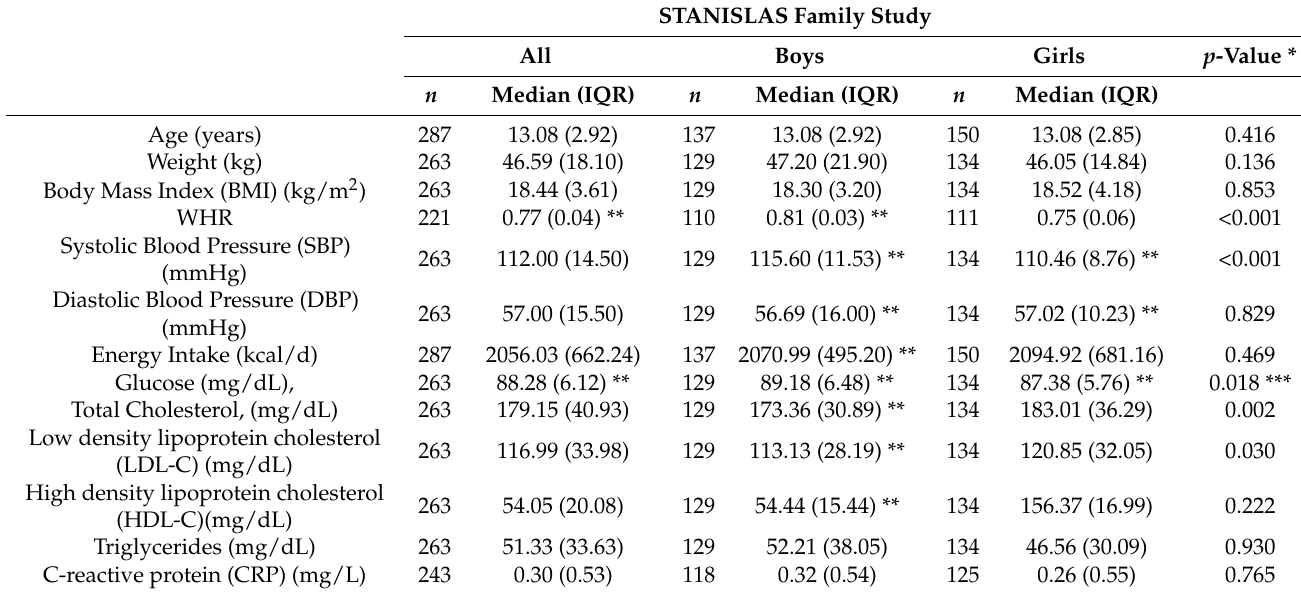
Table 2. Anthropometric, biochemical and dietary characteristics of the STANISLAS Family Study